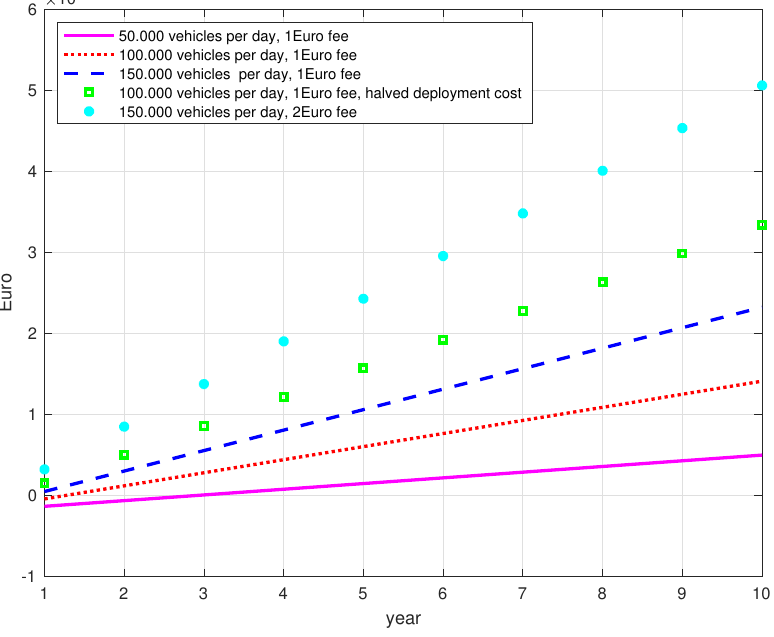
Figure 1. Achieved profit in Euro for different scenarios in a 10-year